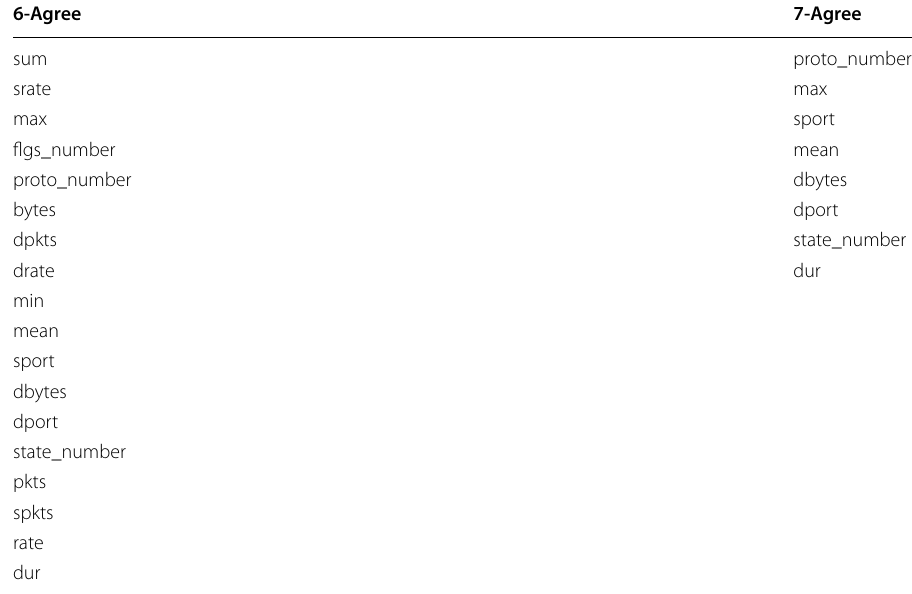
Table 58 Results of the 6-Agree and 7-Agree FSTs